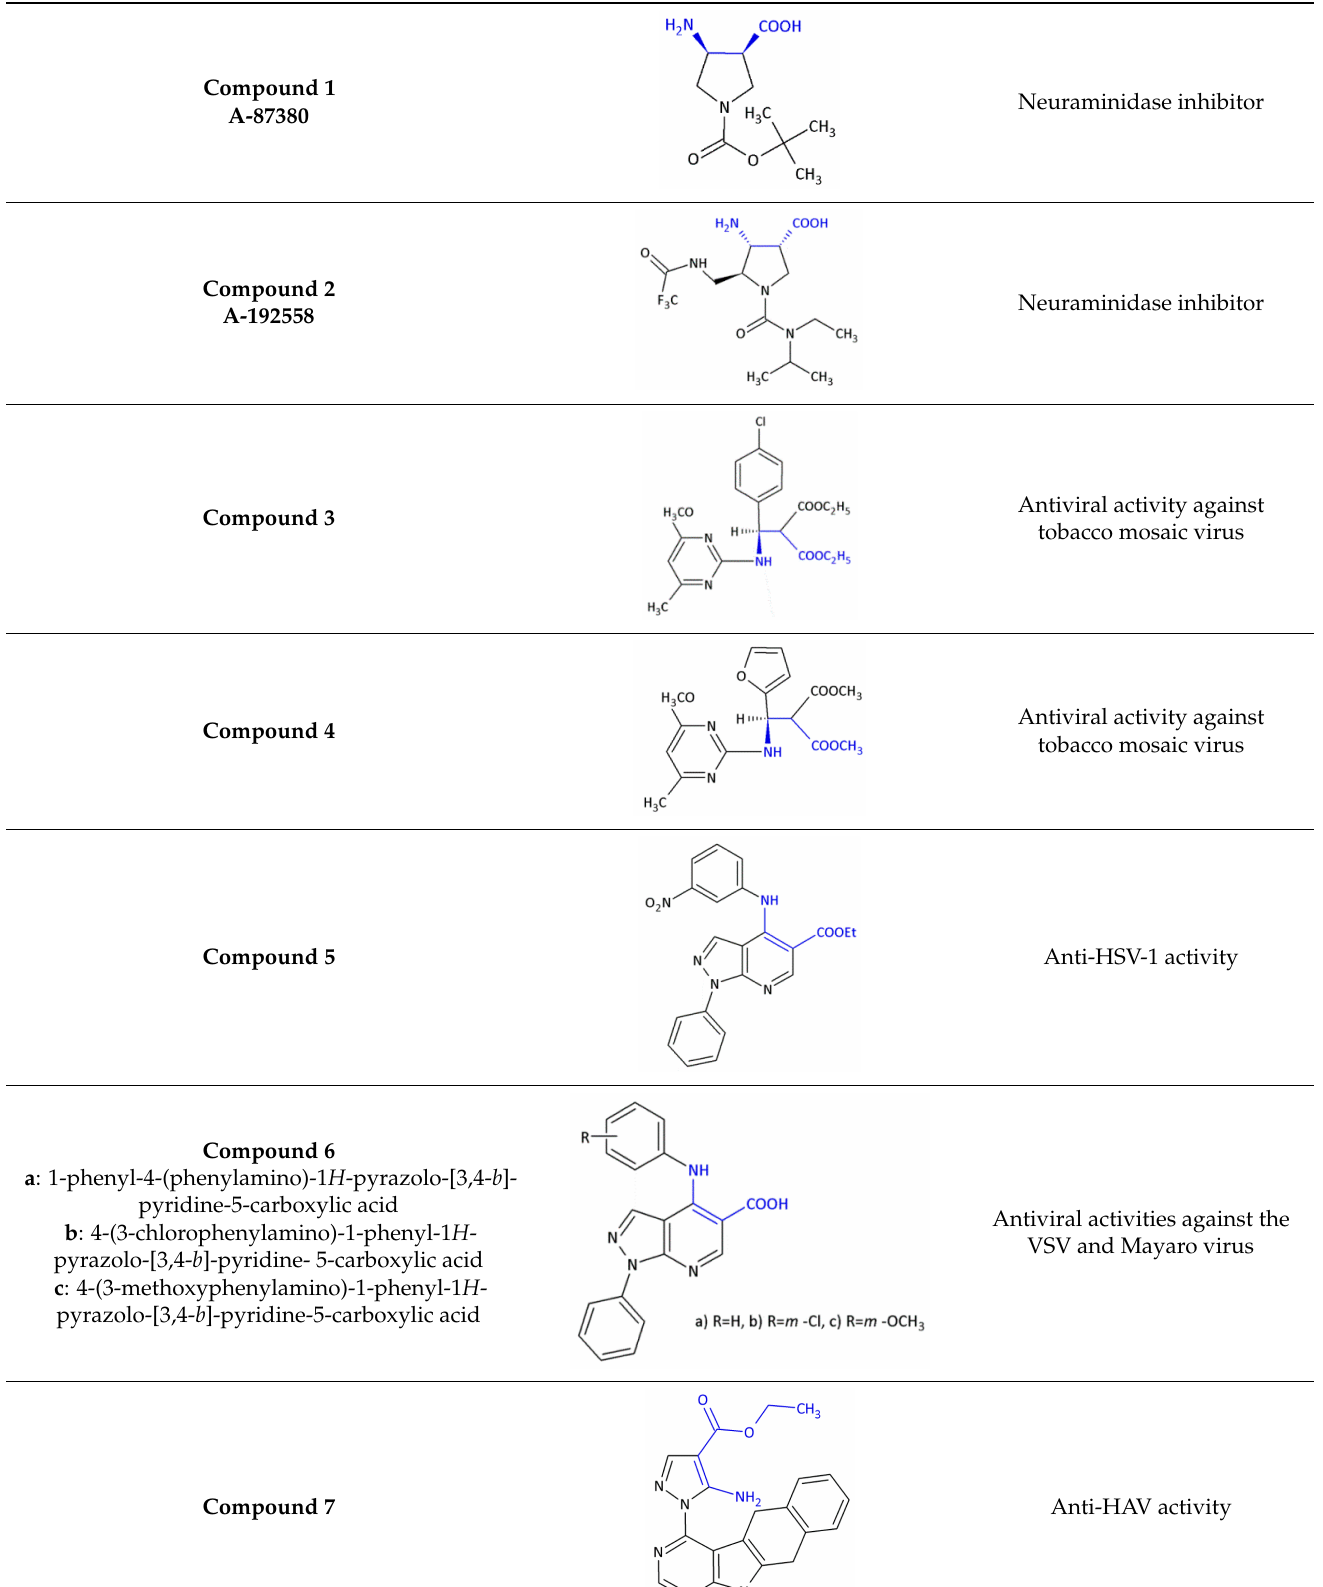
Table 1. Schematic presentation of β 2,3 -amino acid heterocyclic derivatives with antiviral